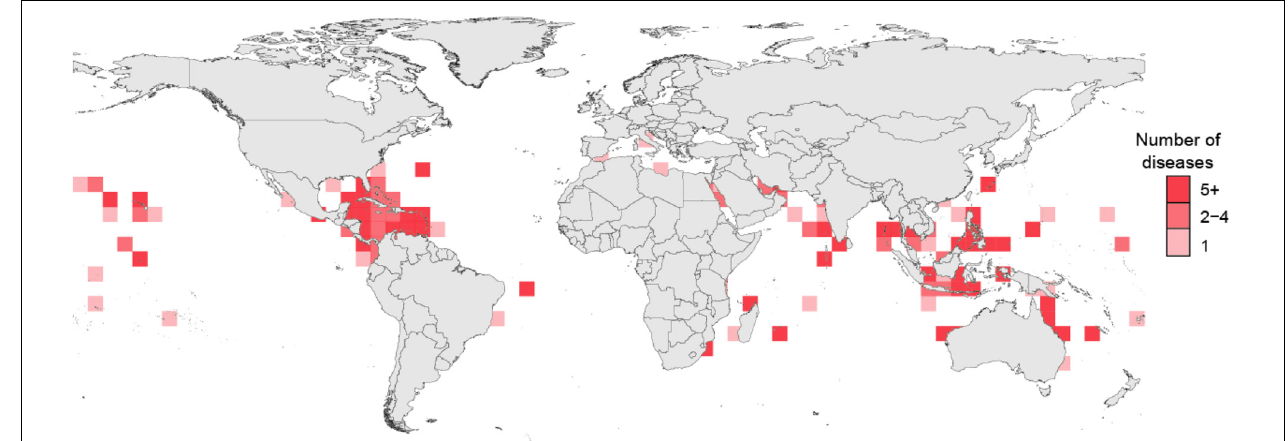
FIGURE 1 | Recorded coral disease richness from surveys published between 1973 and 2020.